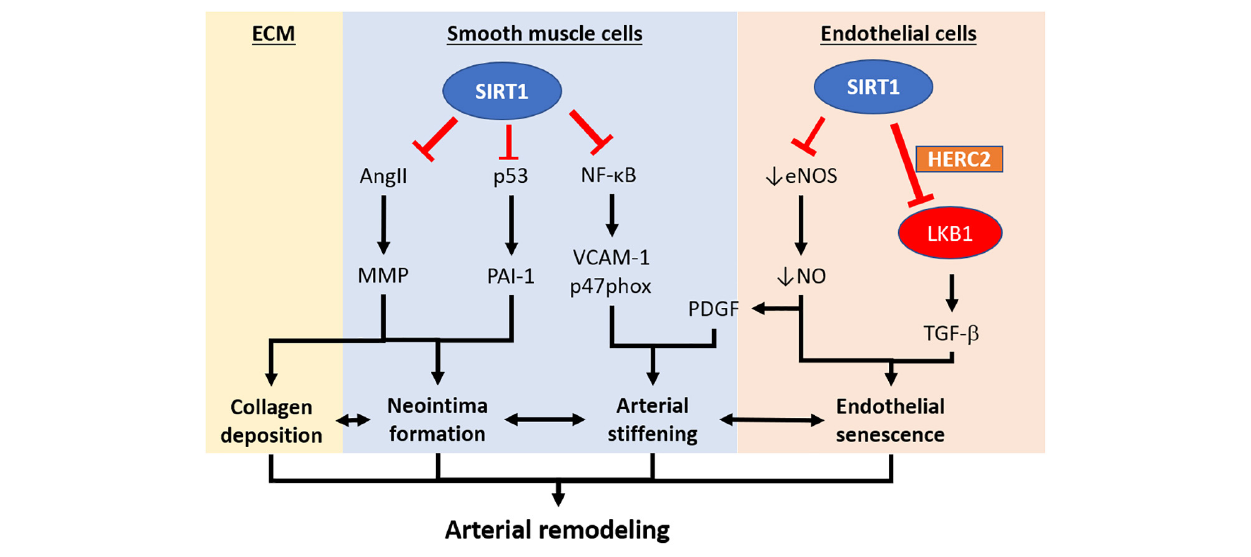
FIGURE 2 | Pathways implicating the development of arterial remodeling and the role of SIRT1 in targeting arterial remodeling. Arterial remodeling is the structural alteration of arteries resulting from endothelial senescence/dysfunction, SMC activation, and changes in the extracellular matrix. Based on the current limited literature, SIRT1 in vascular smooth muscle cells is responsible for repressing neointima formation via a p53-PAI-1 pathway and inhibits Ang-II induced remodeling and intimal thickening. SIRT1 in vascular smooth muscle cells also prevents arterial stiffening via inhibition of NF- κ B and downregulation VCAM-1 and p47phox. Endothelial SIRT1 facilitates protein complex formation with HERC2 and LKB1, which in turn, enhances LKB1 degradation and downregulation of TGF β -signaling. SIRT1-HERC2-LKB1 axis prevents arterial remodeling by targeting endothelial senescence and SMC activation. NF- κ B, nuclear factor kappa-light-chain-enhancer of activated B cells. VCAM-1, vascular cell adhesion protein 1. AngII, angiotensin II. MMP, matrix metalloproteinase. PAI-1, plasminogen activator inhibitor-1. TGF β , transforming growth factor-beta. NO, nitric oxide. PDGF, platelet-derived growth factor. HERC2, HECT and RLD domain containing E3 ubiquitin-protein ligase